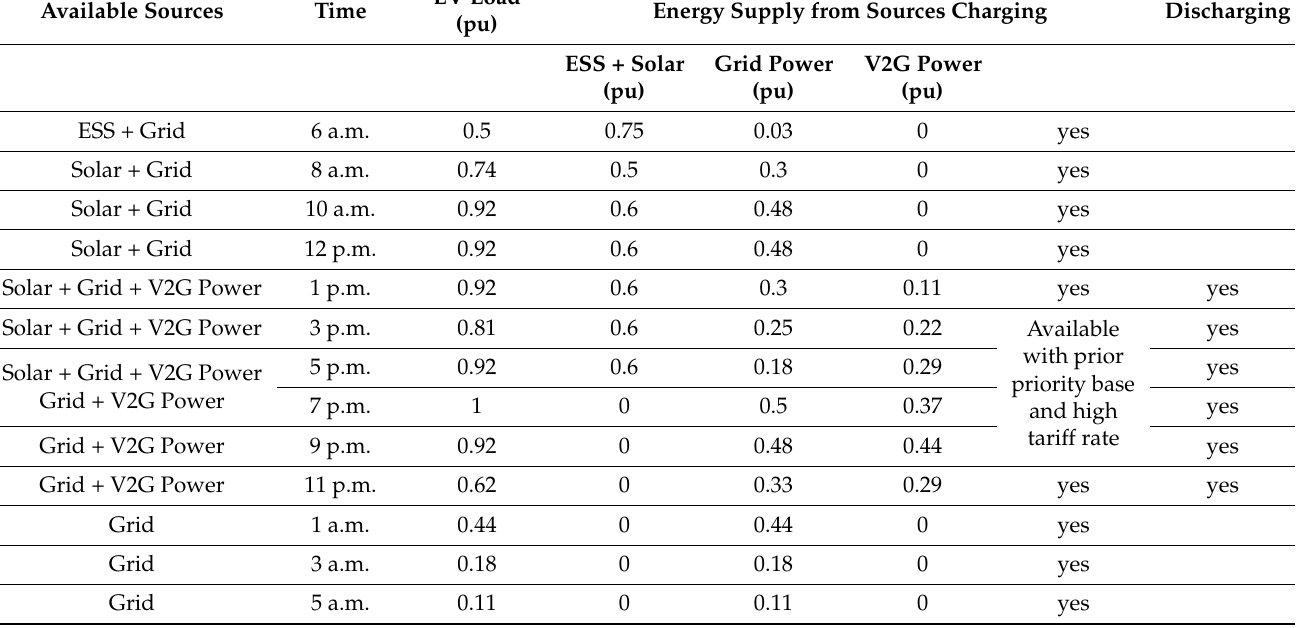
Table 1. EV charging/discharging